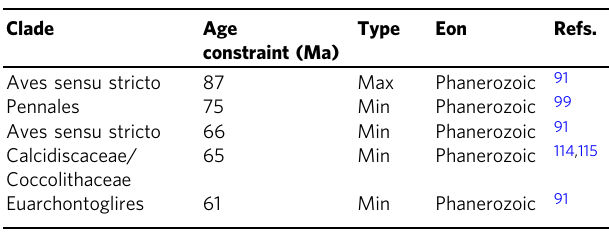
Table 1 Calibrations used for dating the eukaryote tree of